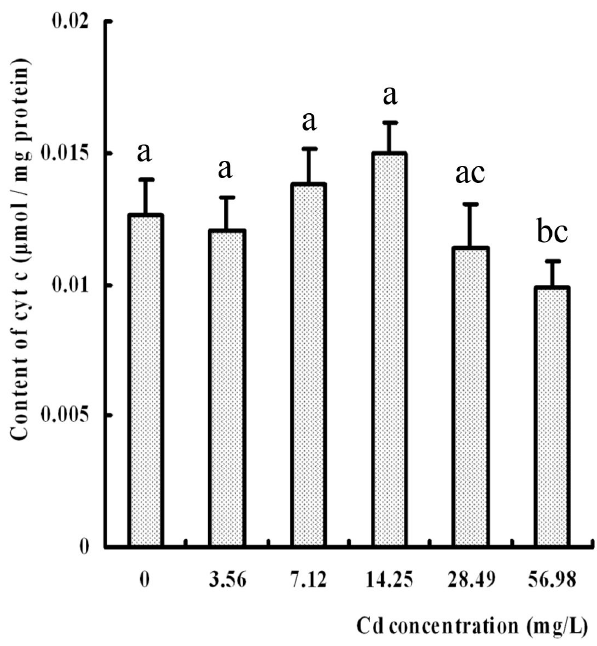
Figure 5. Effect of Cd on the content of cytochrome c in the S. henanense hepatopancreas. No significance between the Cd-treated and the control groups were observation except the 56.98 mg/L group markedly reduction, compared with control, different letter indicated p < 0.05 ( n = 6).